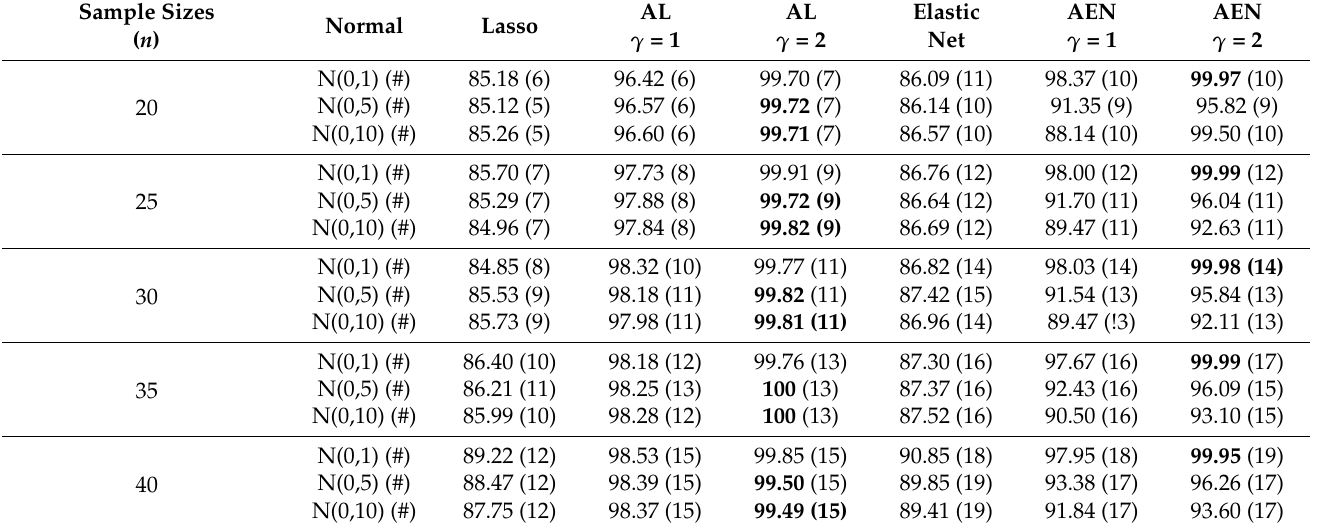
Table 5. The average percentage of accuracy and the average number of selected variables (#) of lasso, adaptive lasso (AL), elastic net, and adaptive elastic net (AEN) under 50